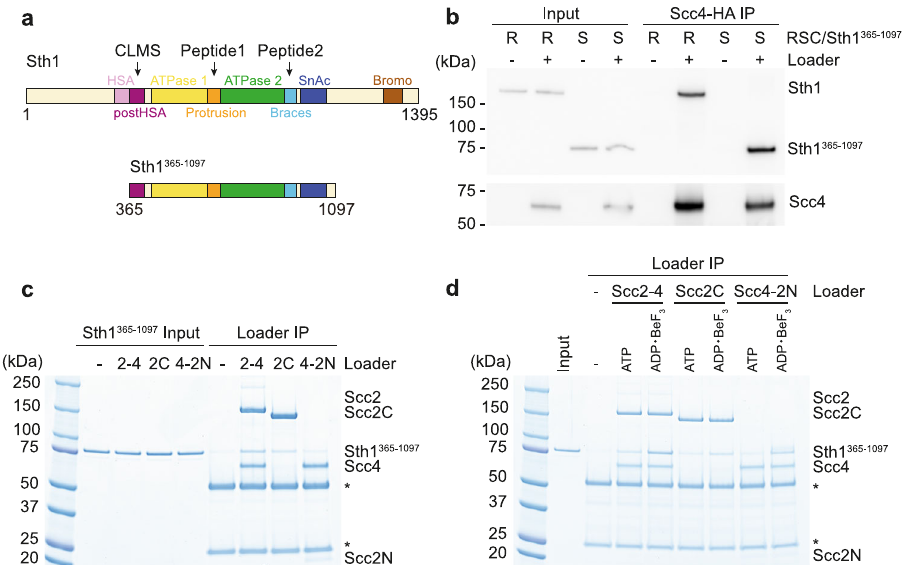
Fig. 2 | Scc2-Scc4 binds the RSC ATPasedomain. a Schematic representing Sth1 domain architecture and the Sth1 365 – 1097 construct (CLMS, cross linking mass spectrometry; HSA, helicase-SANT-associated; SnAc, Snf2 ATP coupling domains). The positions of the CLMS contact and peptide array interactions are indicated. b InteractionbetweenScc2-Scc4andSth1 365 – 1097 .Equimolaramountsof cohesinloaderandeithertheRSCcomplexorSth1 365 – 1097 weremixed,followedby cohesin loader immunoprecipitation (IP). Sth1 coprecipitation was analyzed by immunoblotting. c Sth1 365 – 1097 interaction with Scc2-Scc4 (2-4), Scc2C (2C) or